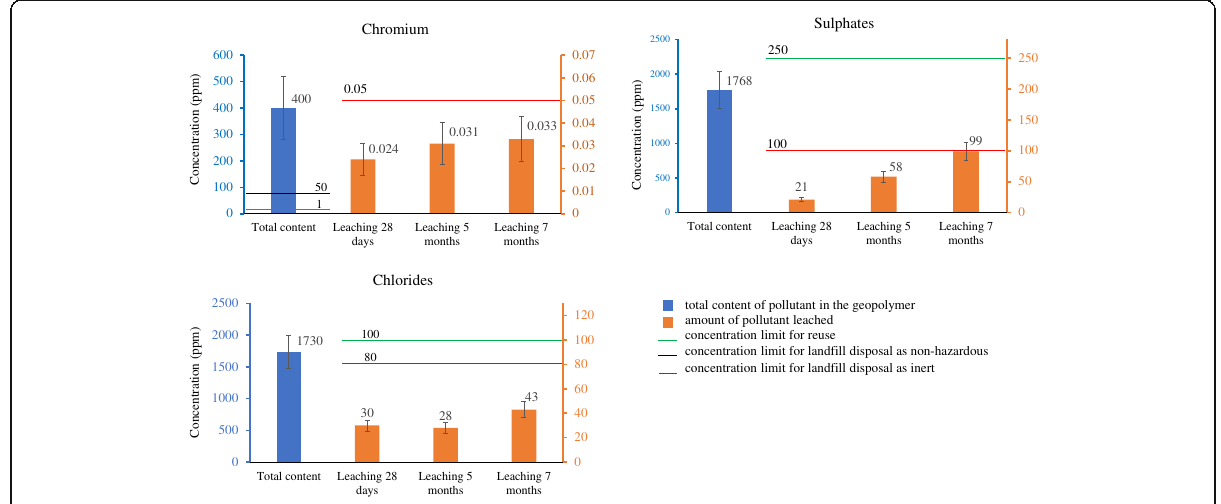
Fig. 3 Main pollutants comparison after leaching tests on the MK produced using tannery wastewater as received. Limits shown refer to the current Italian regulation. All values are reported in